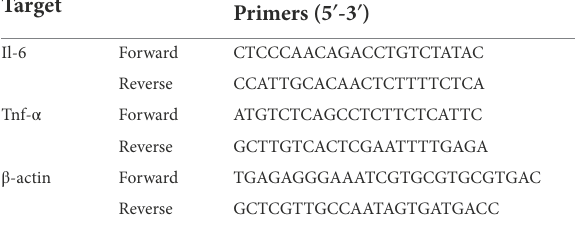
TABLE 1 Nucleotide sequence of primers used for